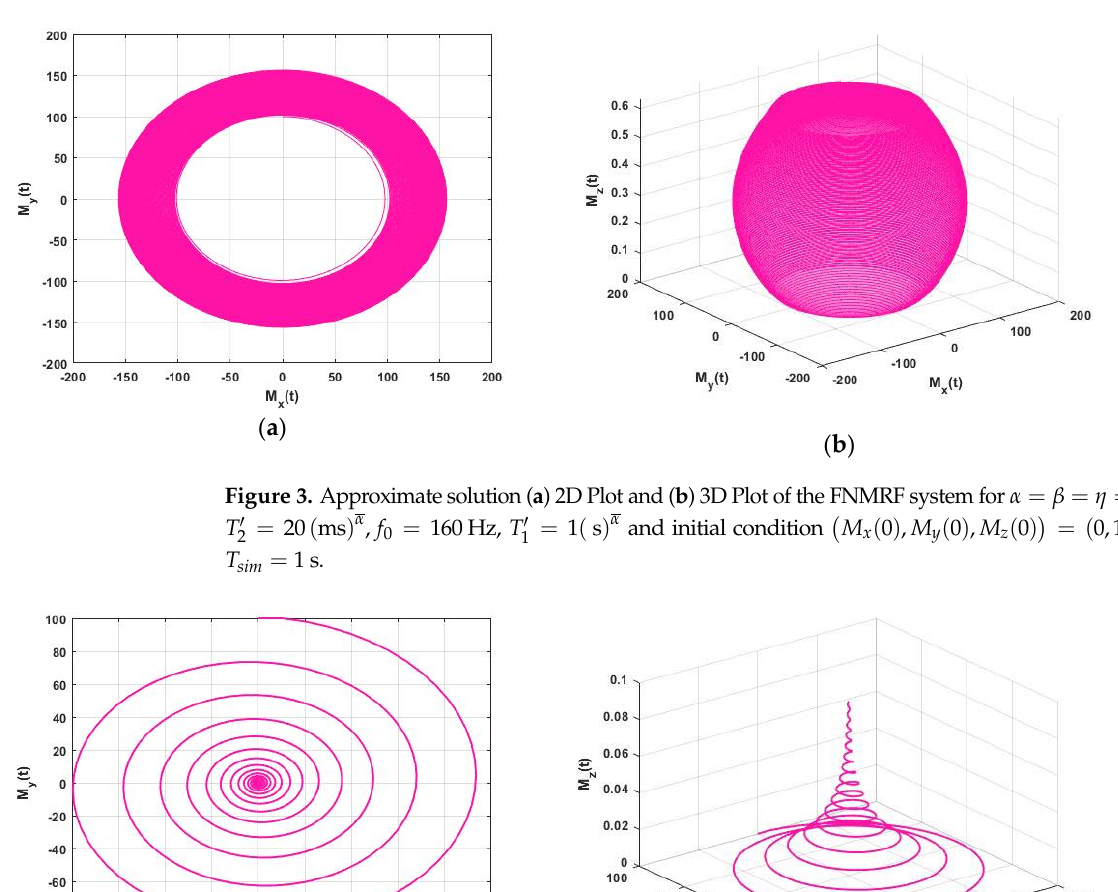
Figure 2. Approximate solution ( a ) 2D Plot and ( b ) 3D Plot of the FNMRF system for 𝛼 (cid:3404) 𝛽 (cid:3404) 𝜂 (cid:3404)